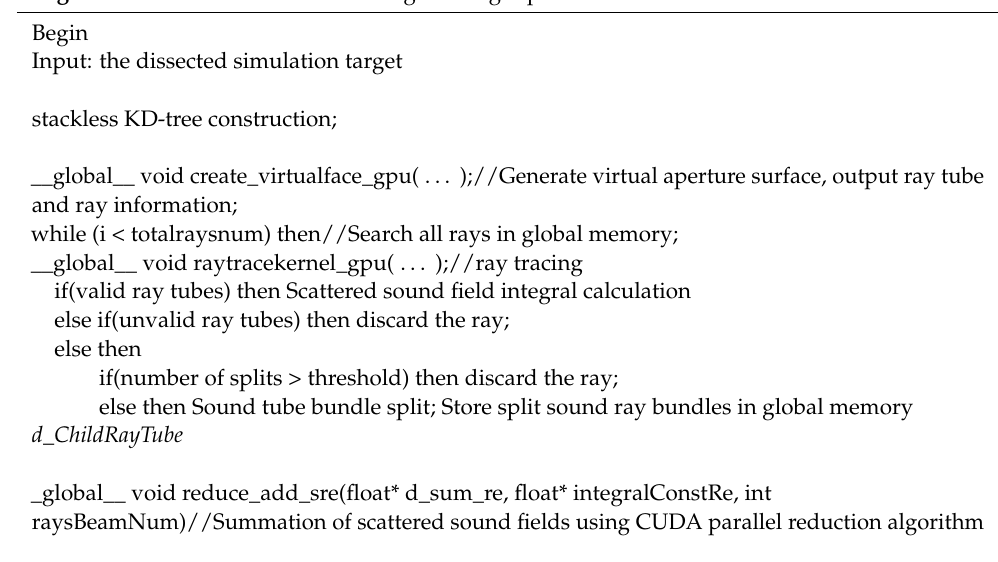
Figure 5. The GPU-accelerated target strength prediction based on multiresolution SBR. Algorithm 1 The GPU-accelerated target strength prediction based on multiresolution